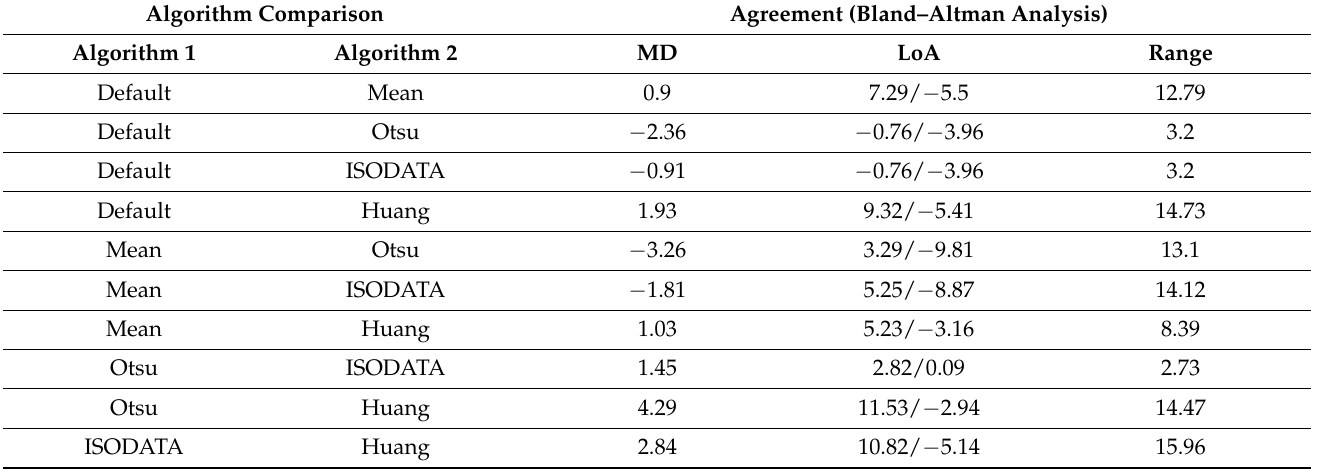
Table 5. Bland–Altman analysis for inter-algorithm agreement in the choriocapillaris slabs for the entire study cohort.